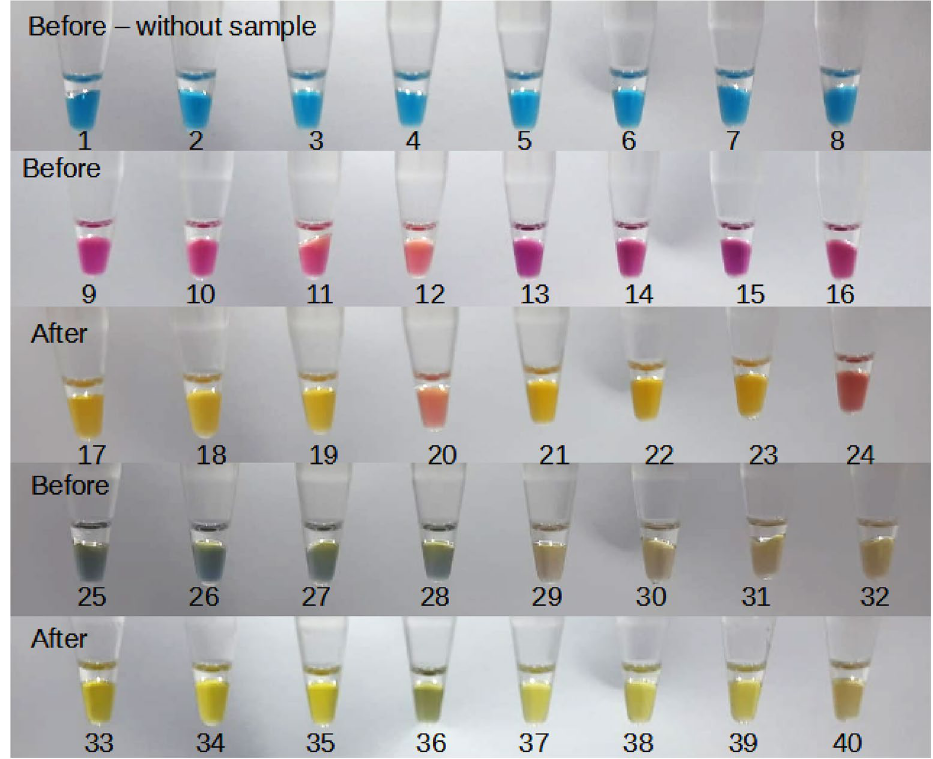
Figure 4. Reactions with different dyes before and after incubation at 67 °C for 30 min. Tubes 1–8 contained only bromothymol blue, showing the color of the reaction before the sample was added. The sample solutions contained either phenol red or cresol red. Tubes 9–16 represent tubes 1–8 after the sample addition with a solution containing phenol red, and tubes 17–24 are after incubation at 67 °C for 30 min. Tubes 25–32 represent tubes 1–8 after the sample addition with a solution containing cresol red, and after an incubation of 67 °C for 30 min, the results were the tubes 33–40. Tubes 12, 16, 28, and 32 were non-template controls. The final concentration of dyes in the tubes was: tubes 1–4 contained 50 μM bromothymol blue; 5–8 contained 100 μM bromothymol blue; 9–12 and 17–20 contained 50 μM bromothymol blue and 100 μM phenol red; 13–16 and 21–24 contained 100 μM bromothymol blue and 100 μM phenol red; 25–28 and 33–36 contained 100 μM bromothymol blue and 100 μM cresol red; 29–32 and 37–40 contained 50 μM bromothymol blue and 100 μM cresol